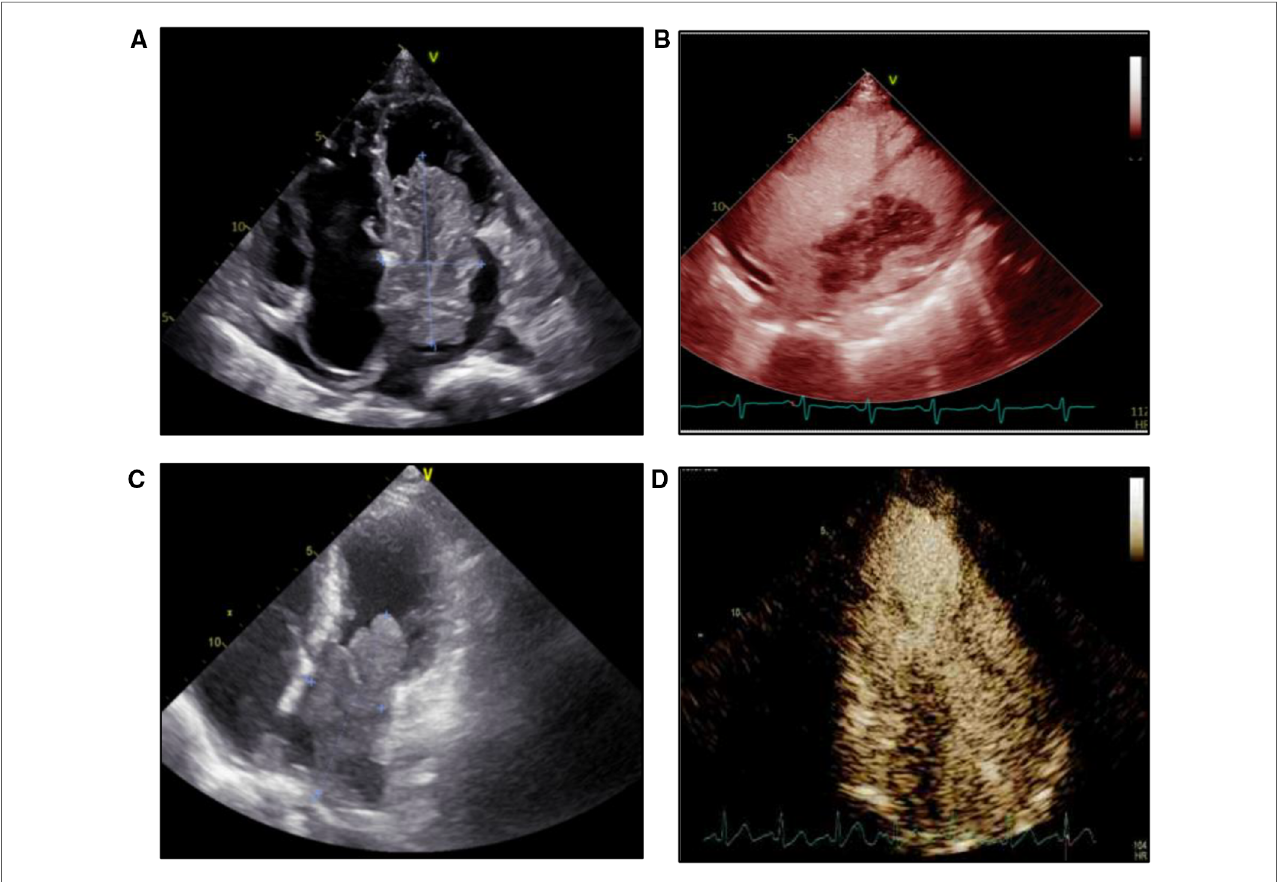
FIGURE 3 Echocardiography and microbubble contrast-enhanced echocardiography images of patients with benign or malignant primary atrial tumor. ( A ) Echocardiography image of a patient with cardiac myxoma. ( B ) Microbubble contrast-enhanced echocardiography image of a patient with cardiac myxoma. ( C ) Echocardiography image of a patient with intimal sarcoma. ( D ) Microbubble contrast-enhanced echocardiography image of a patient with intimal